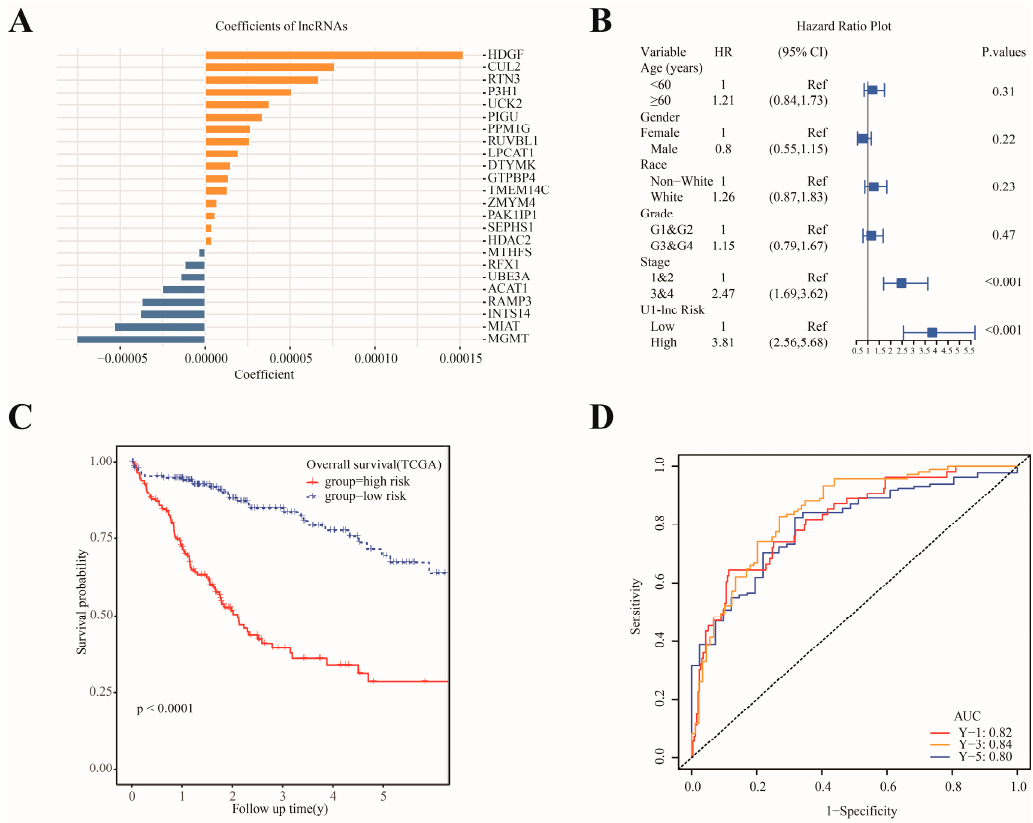
Figure 5. Construction of a prognostic model based on U1-lncRNAs and associated mRNAs to predict the survival of patients in TCGA-LIHC cohort. ( A ) Coefficients of selected U1-lncRNA and associated mRNAs by LASSO. ( B ) Univariate Cox regression analysis of OS for the U1-lncRNA risk score in addition to clinical features. ( C ) Kaplan–Meier curves of OS between the high-risk and low-risk groups in the TCGA cohort. ( D ) ROC curve of 1-, 3- and 5-year survival of the risk model in TCGA cohort.